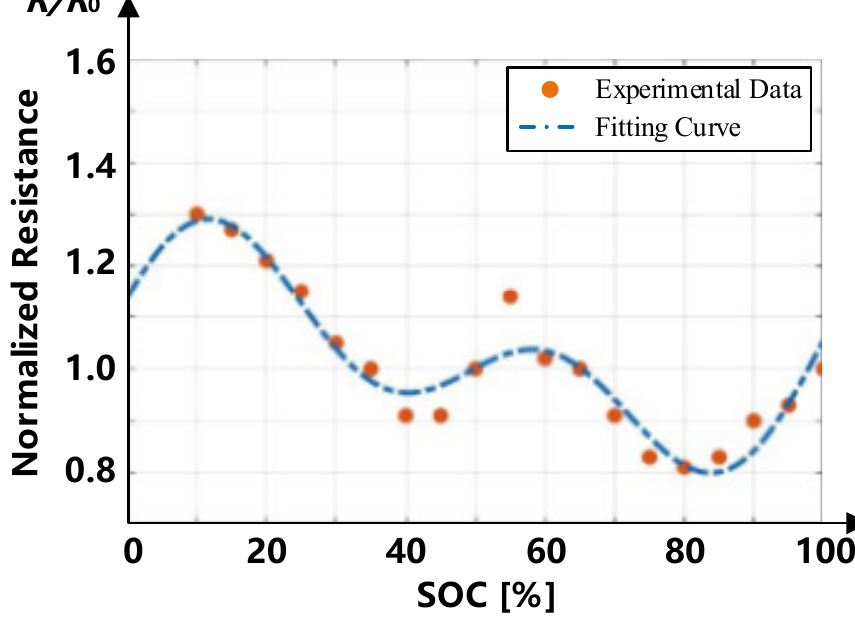
Figure 4. Normalized resistance curve as a function of SOC [8].